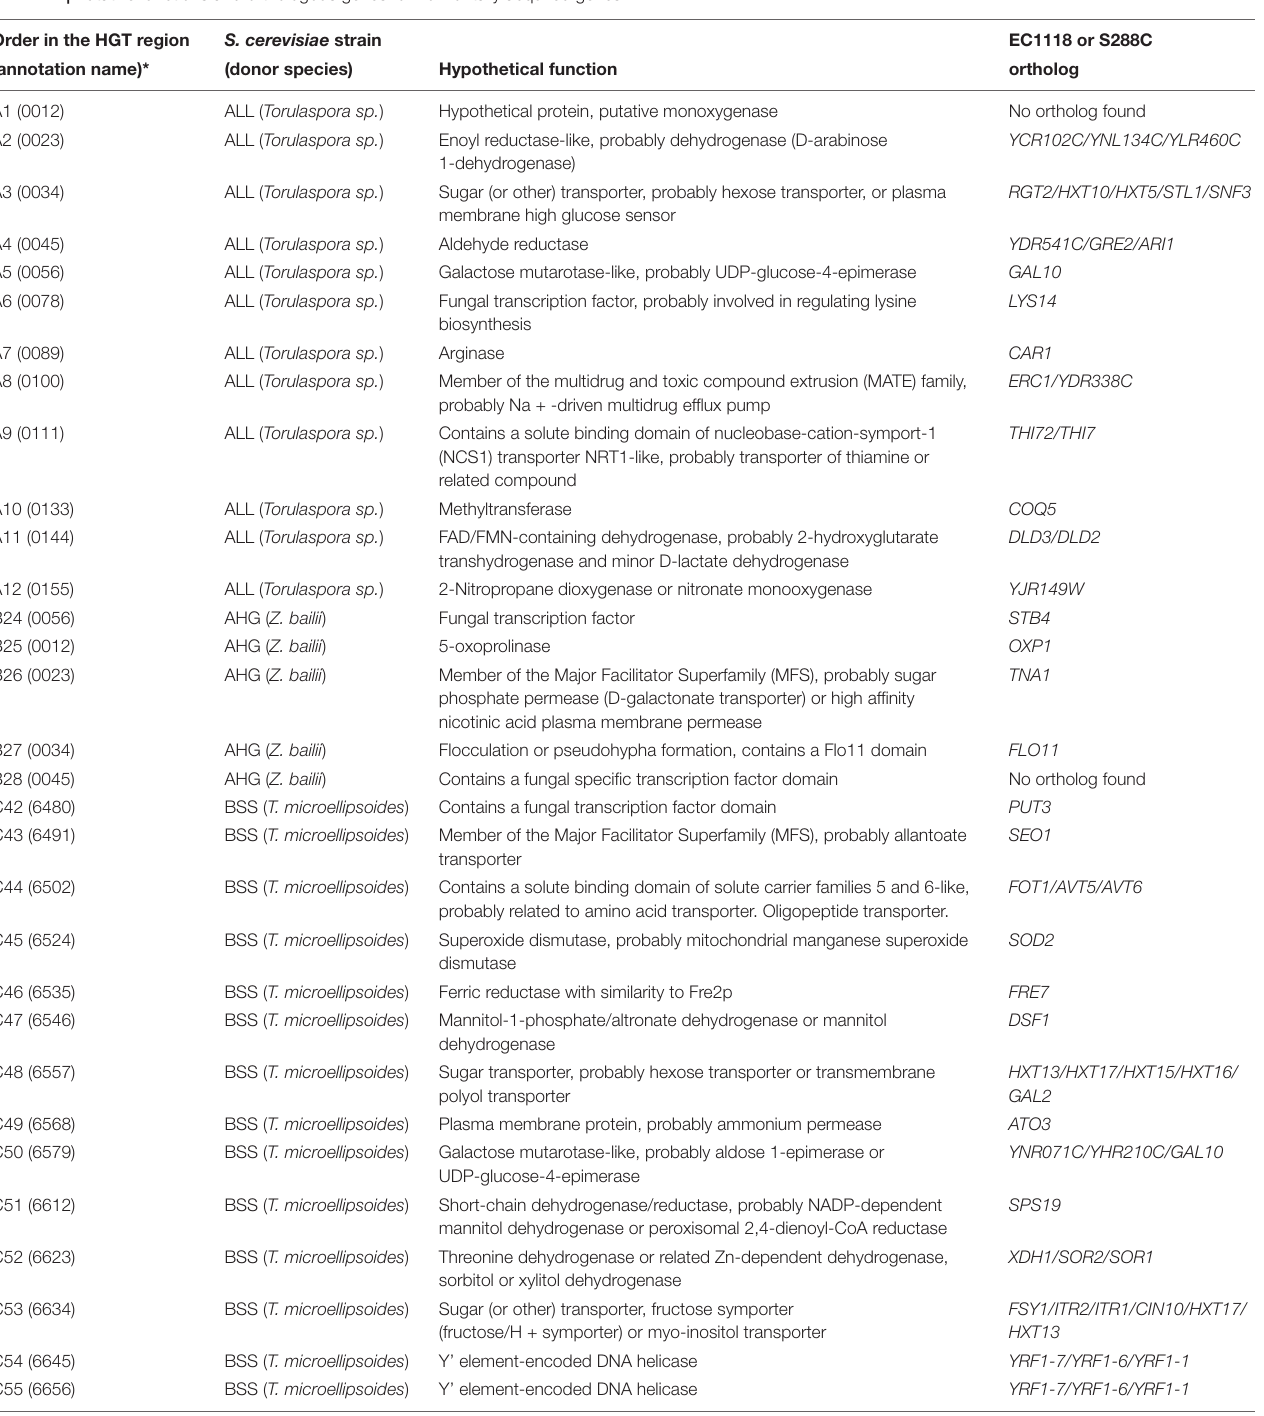
TABLE 1 | Putative functions and orthologous genes for horizontally acquired genes. Order in the HGT